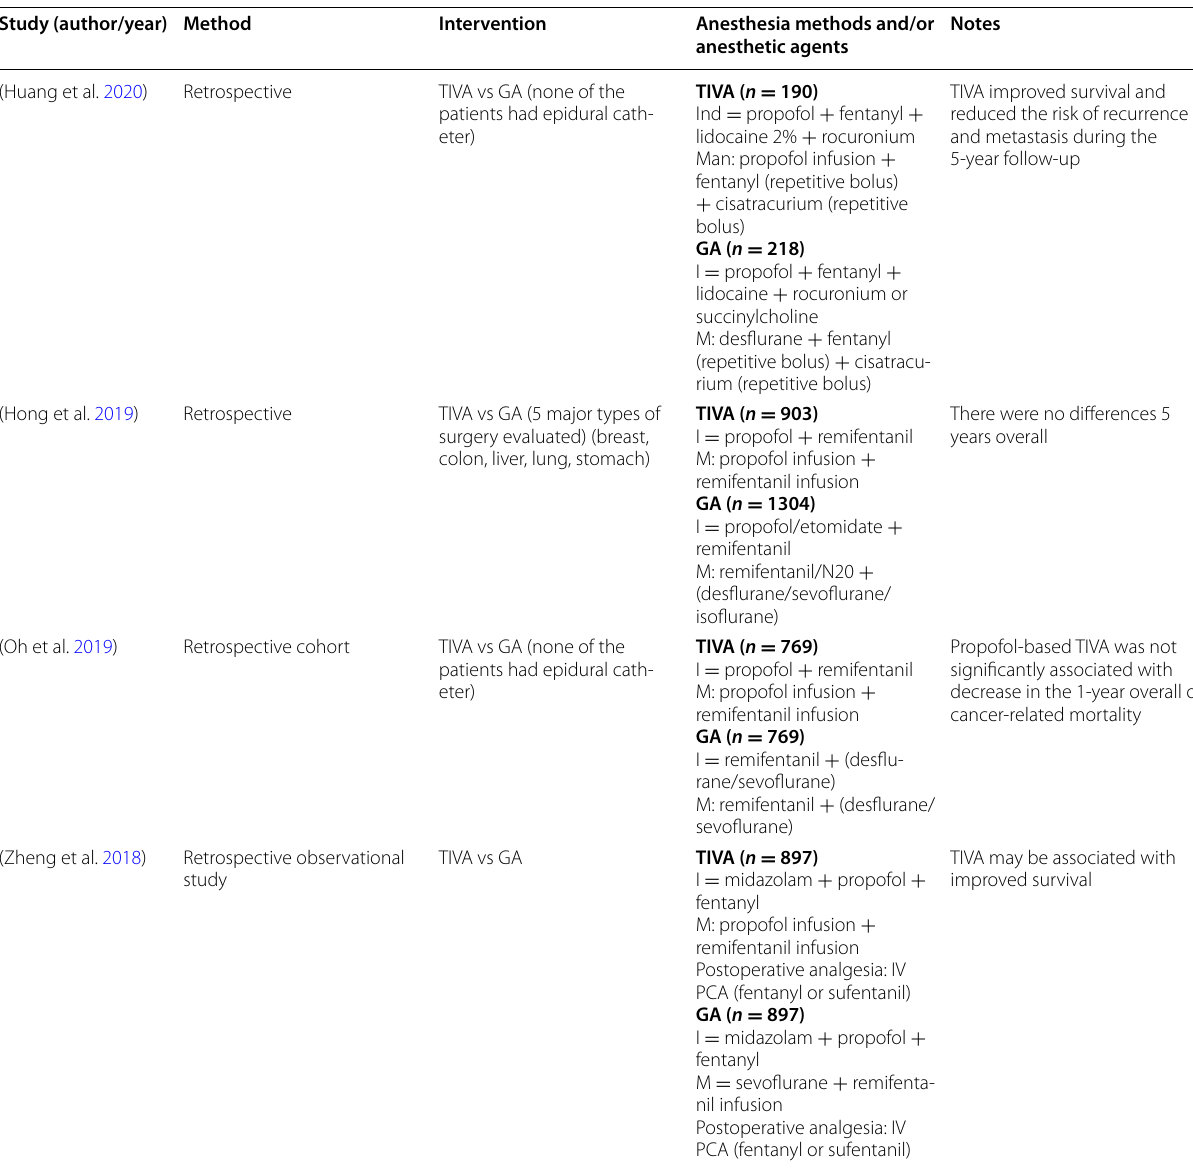
Table 1 Summary of studies on gastric cancer that compare TIVA with GA Study (author/year)